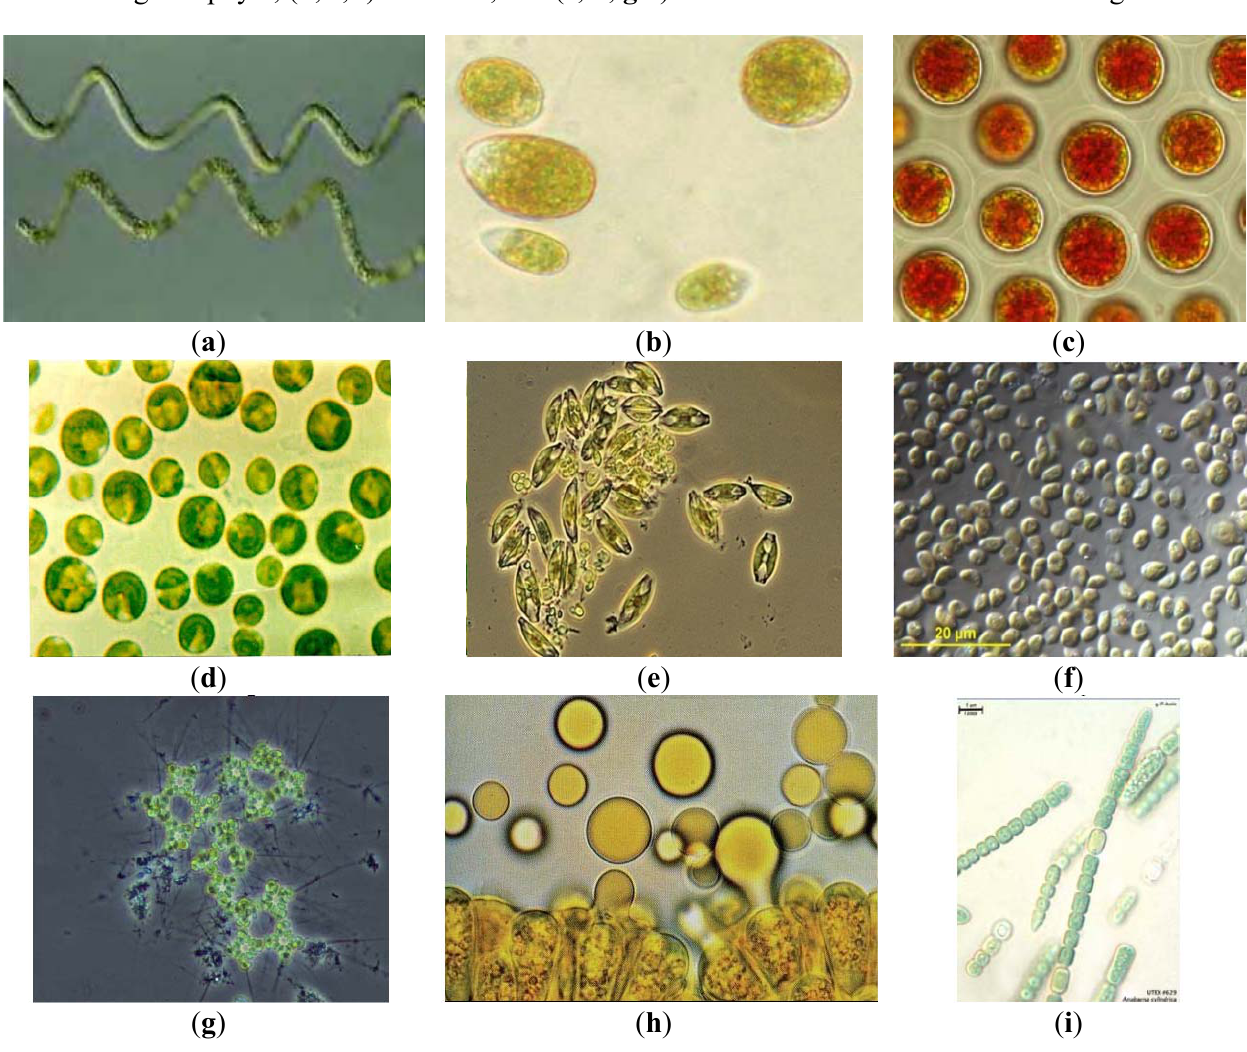
Figure 2. Microalgae commercially cultivated and/or of interest in biofuels/feeds production: ( a ) Arthrospira platensis (Spirulina), is cultured in high alkalinity (~16 g/L bicarbonate) waters; ( b ) Dunaliella salina grows at high salinity (>100 g/L, >3× seawater), produces beta-carotene; ( c ) Haematococcus pluvialis , red color due to astaxanthin, a carotenoid used in aquaculture feeds and nutritional products; ( d ) Chlorella vulgaris , first microalgae produced commercially for human foods; ( e ) Amphora sp. , as with most diatoms, requires large amounts of silicate, increasing production costs; ( f ) Nannochloropsis sp. , ( g ) Micractinium sp. , grown in wastewater, can aggregate into large flocs (“bioflocculation”); ( h ) Botryococcus braunii , a unique hydrocarbon producing species (see oil droplets release); and ( i ) Anabaena cylindrica , a nitrogen-fixing cyanobacterium with potential for fertilizer production. Notes: ( a – d ) currently commercially grown species; ( a ) and ( i )